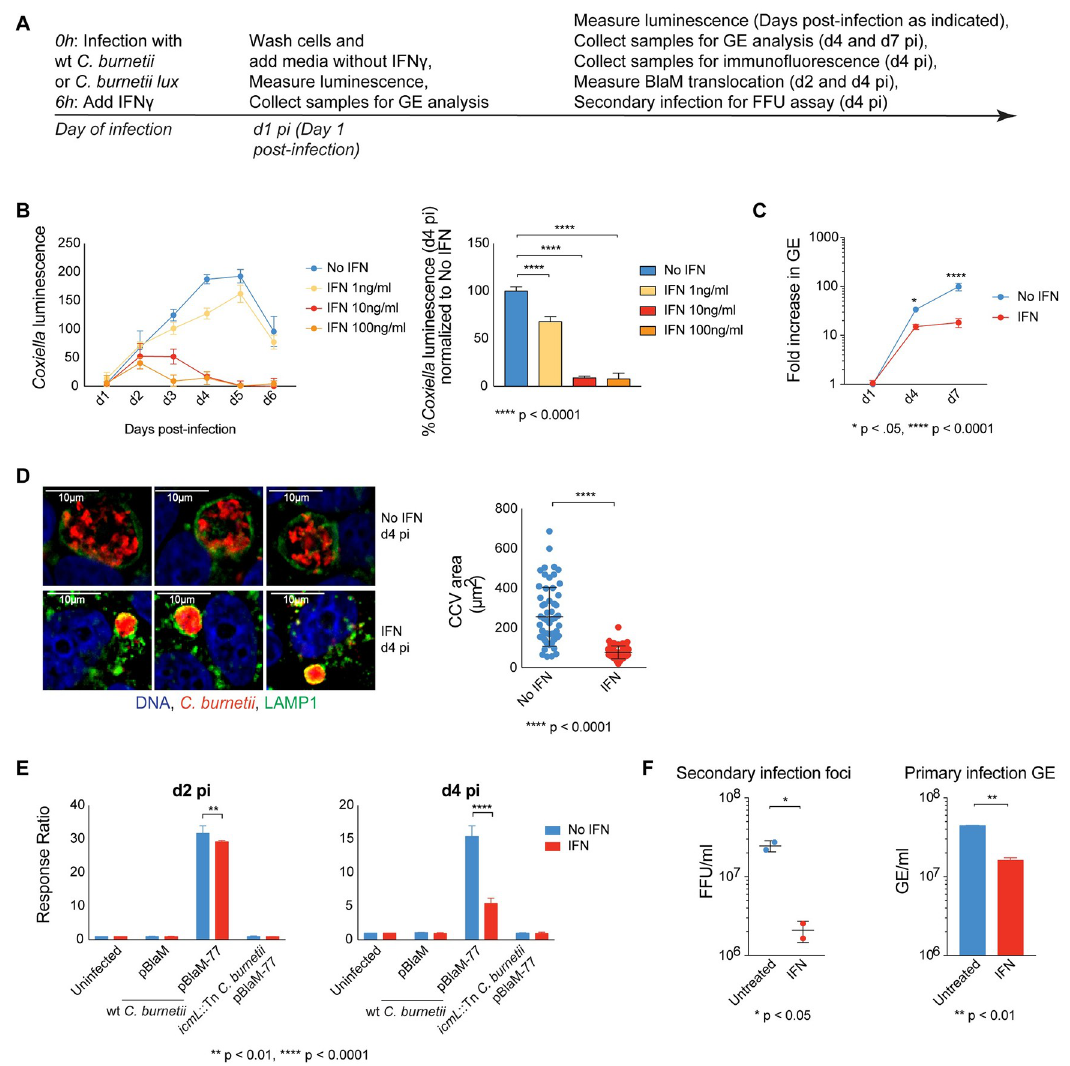
Fig 1. IFN γ restricts C . burnetii intracellular replication, CCV size, effector translocation and bacterial infectivity. Experimental setup is laid out in A. HeLa cells were infected with C . burnetii lux (B) or wt C . burnetii (C-F) and treated with recombinant IFN γ at 10ng/ml (C-F) or as indicated (B). C . burnetii replication was monitored by measuring luminescence values on indicated days post-infection (B) or by fold increase in genome equivalents (GE) on d4 and d7 pi compared to that of d1 pi (C). CCV and the intracellular bacteria were visualized by indirect immunofluorescence with anti-LAMP1 and anti- C . burnetii antibodies on d4 pi (D). Average CCV area for approximately 50 vacuoles from different fields were quantified per treatment and averaged (D). HeLa cells were infected with C . burnetii pBlaM or pBlaM-77 and left untreated or treated with IFN γ . On d2 and d4 pi, cells were loaded with the fluorescent substrate CCF4-AM and translocation of BlaM was assessed by the shift in the fluorescence emission from 535 to 460nm relative to that of uninfected (E). Focus forming units (FFU) of bacteria obtained from HeLa cells treated with or without IFN γ were determined by secondary infection of untreated HeLa cells and counting of C . burnetii -stained foci on d4 pi (F). Panel to the right shows GE obtained from primary infection